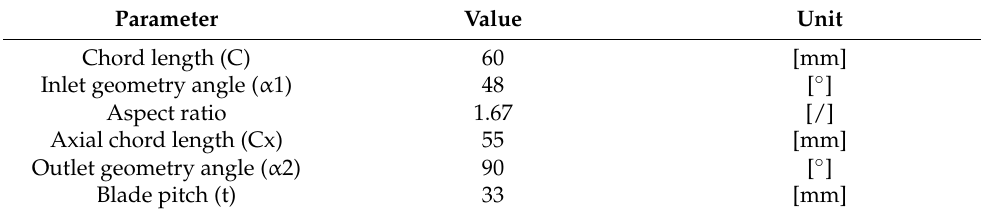
2.30 million Figure 2. Contour of total pressure loss coefficient at various grid points. 3.3. Computational Method Authentication ANSYS ‐ CFX19.2 is used in this paper. Results are obtained with the solution of 3D steady compressible RANS equation and discretizing equation with a finite ‐ volume method. At outlet boundary static pressure is specified. Total pressure and total temperature are given with 5% inlet boundary turbulence intensity. Working fluids utilized for this analysis are fixed as ideal gases. Predicted and experimental static pressure on blade surfaces is shown in Figure 3. SST turbulence model with γ‐ Re θ turbulence transition model gives a precise calculation of static pressure on blade surfaces in comparison with the calculation results and experimental data [21] using various turbulence models.